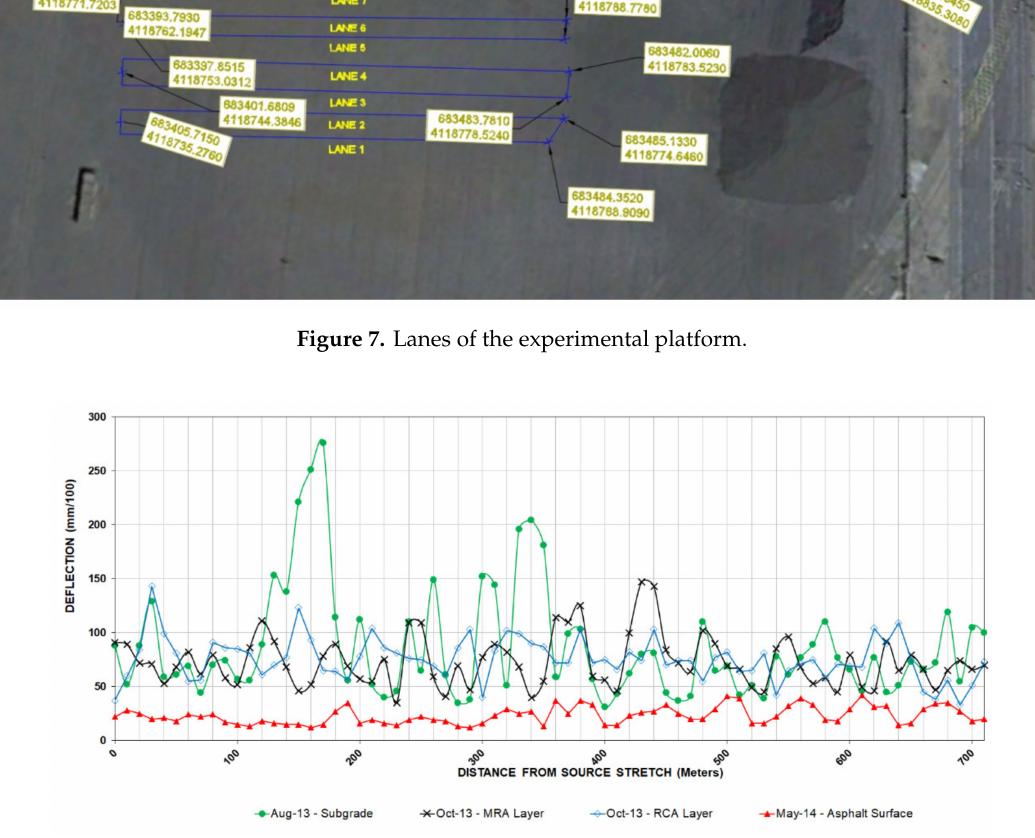
Figure 8. Deflection measurement.